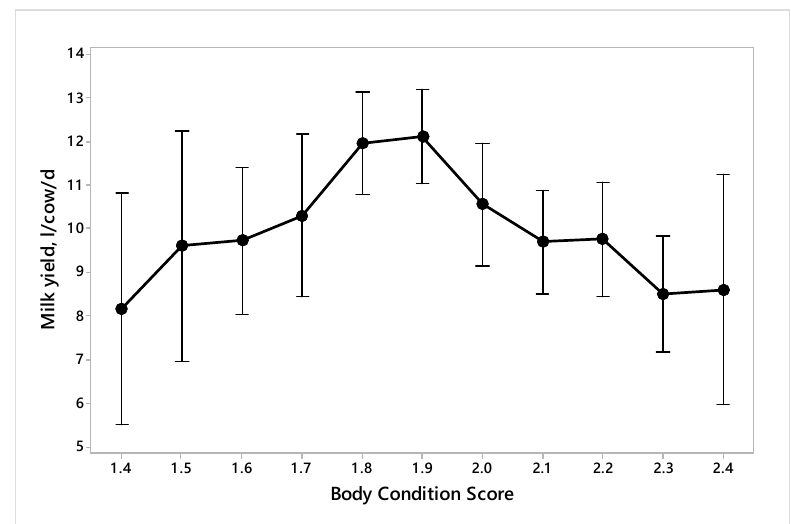
Figure 1. Change in milk yield with body condition score in dairy cows (n = 700) in 70 dairy farms assessed for the welfare of Australian–Zebu cross-bred dairy cattle in different areas of Sirajgonj district, Bangladesh.